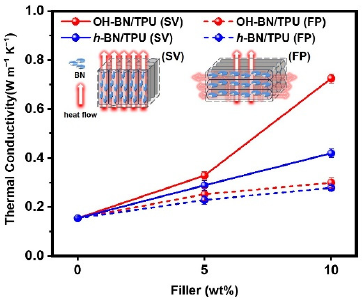
Figure 9. Thermal conductivities of the h -BN/TPU and OH-BN/TPU composites at various filler concentrations, printed in either an SV or FP orientation. The heat conduction pathways through the composites according to the printing orientation are shown in the figure inset.